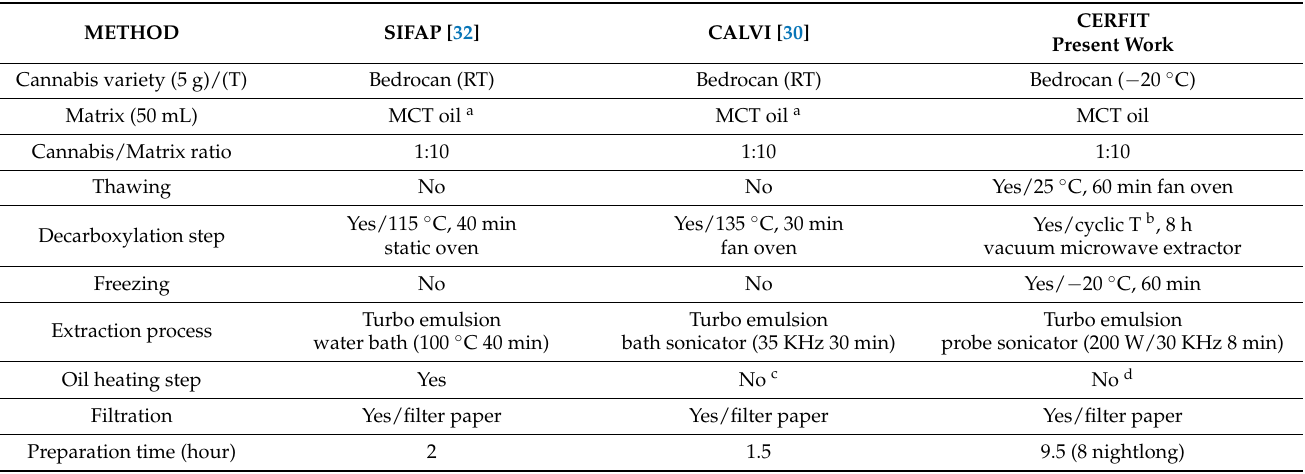
Table 6. Detailed comparison of the three methods used for Cannabis oil preparation in this